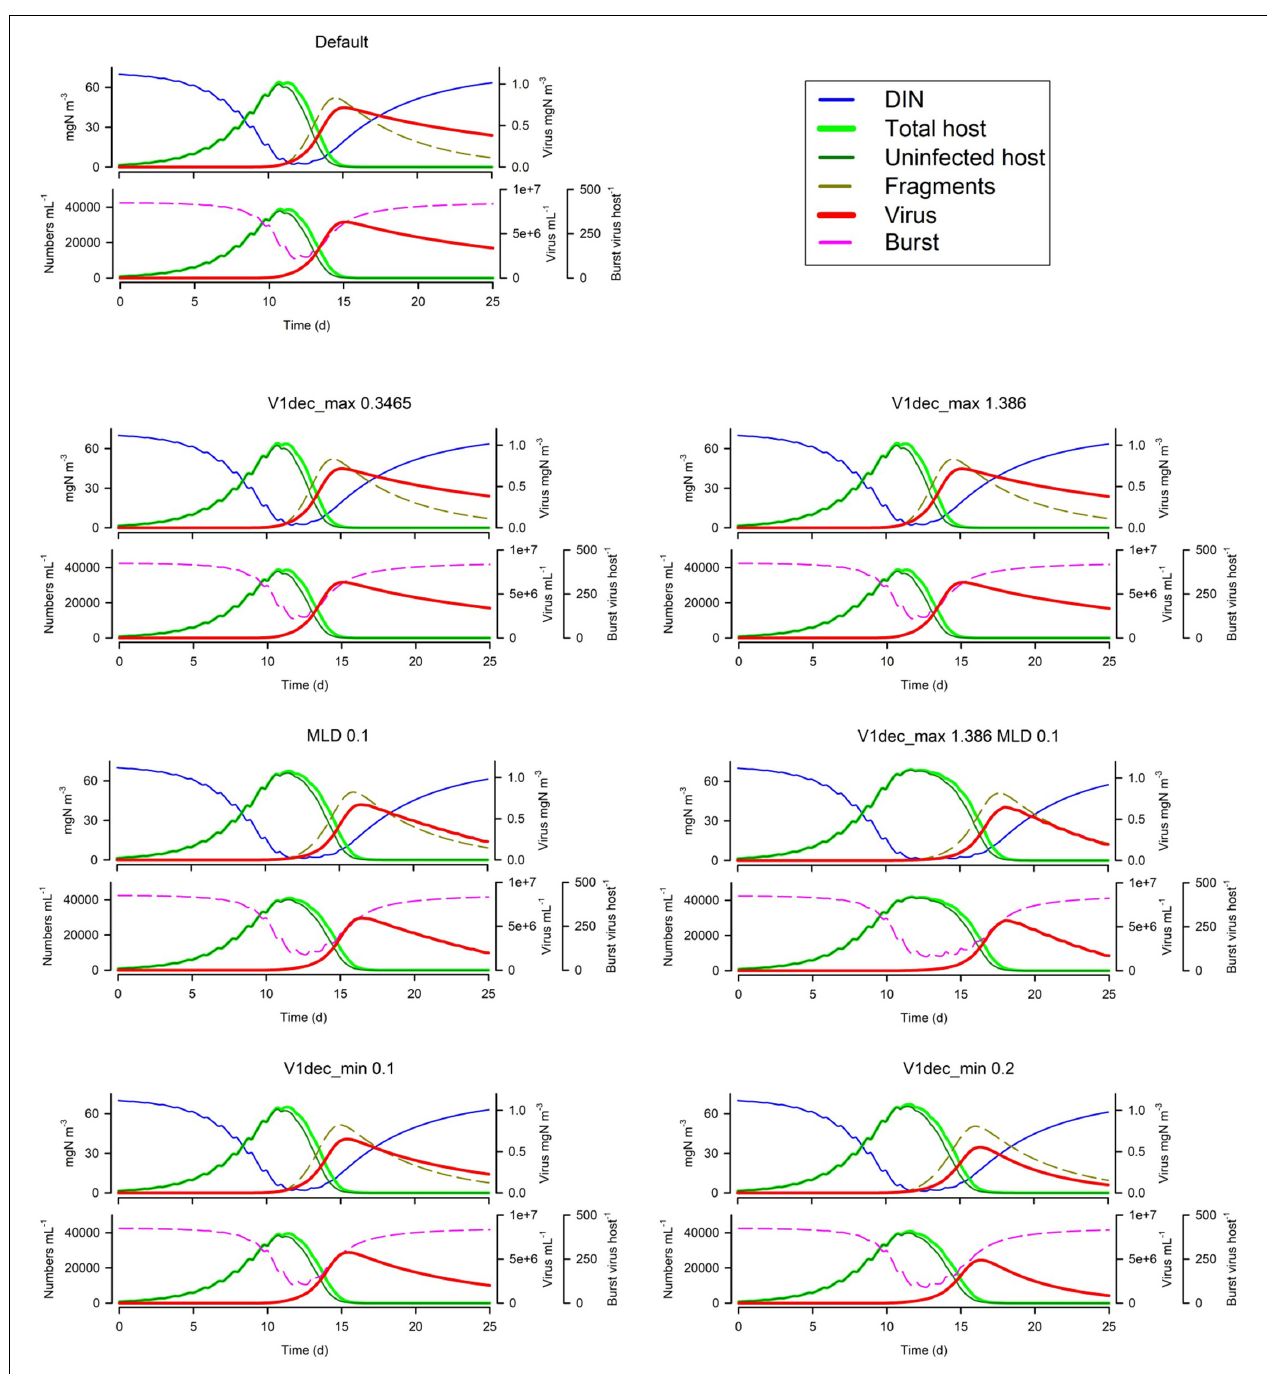
FIGURE 10 | Effects of the maximum (UV-induced) decay rate ( V1dec_max 0.3465 or 1.386 vs Default of 0.693 d − 1 ) at 10m MLD , or at 0.1m MLD for the Default vs V1dec_max = 1.386 d − 1 , and for the minimum decay rate ( V1dec_min 0.1 or 0.2 vs Default of 0.05 d − 1 ). The Default ( Figure 1B ) is reproduced in the top left-hand corner. See also Table 5